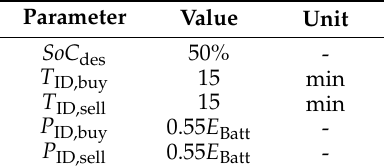
Table 5. Parameter set for illustration.